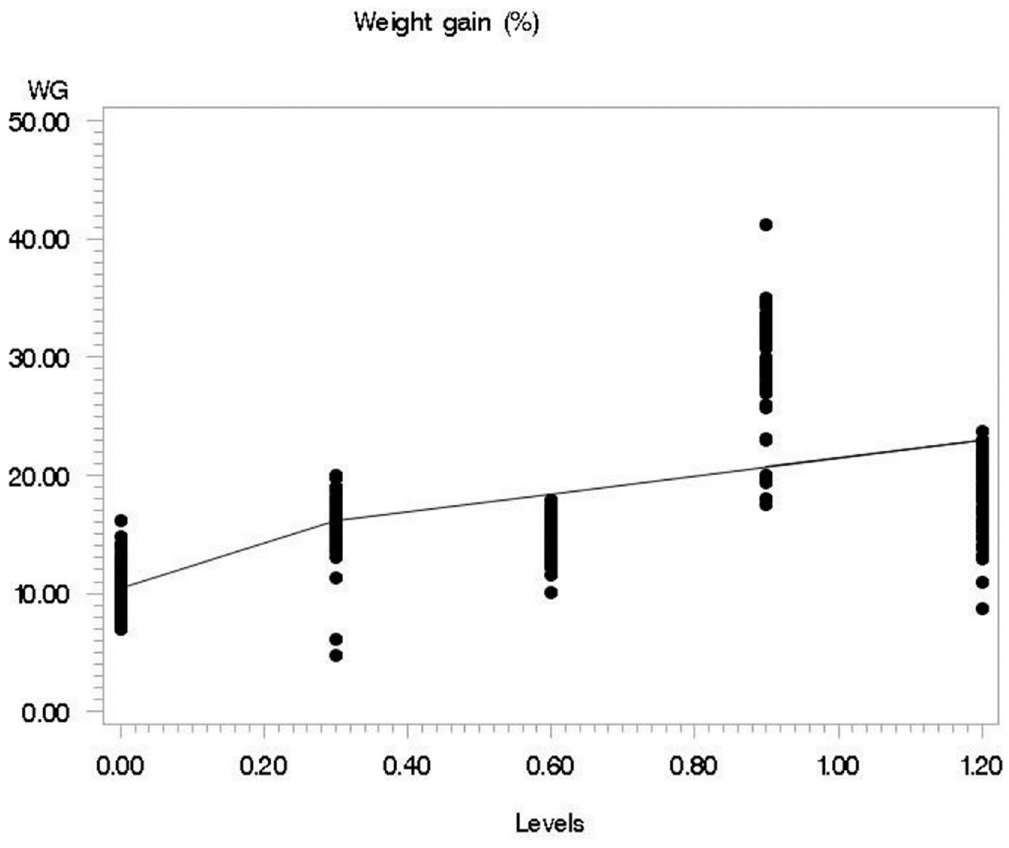
Fig 1. The fitted broken-line plot of % weight gain of Hypophthalmichthys molitrix fed on different levels of selenium methionine. Liner broken-line fitted model for selenium levels; Y = 60.12–0.13 (102-X) × I, I = 1 (if X < 102) or I = 0 (if X > 102), P < . 006 , R 2 = 0.30, the breakpoint occurred at 96 ±